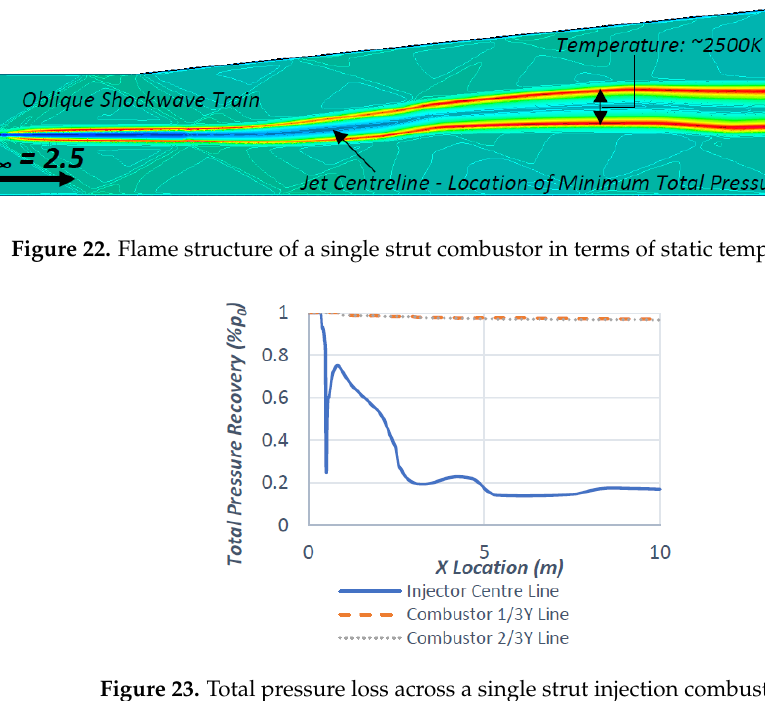
Figure 23. Total pressure loss across a single strut injection combustor.